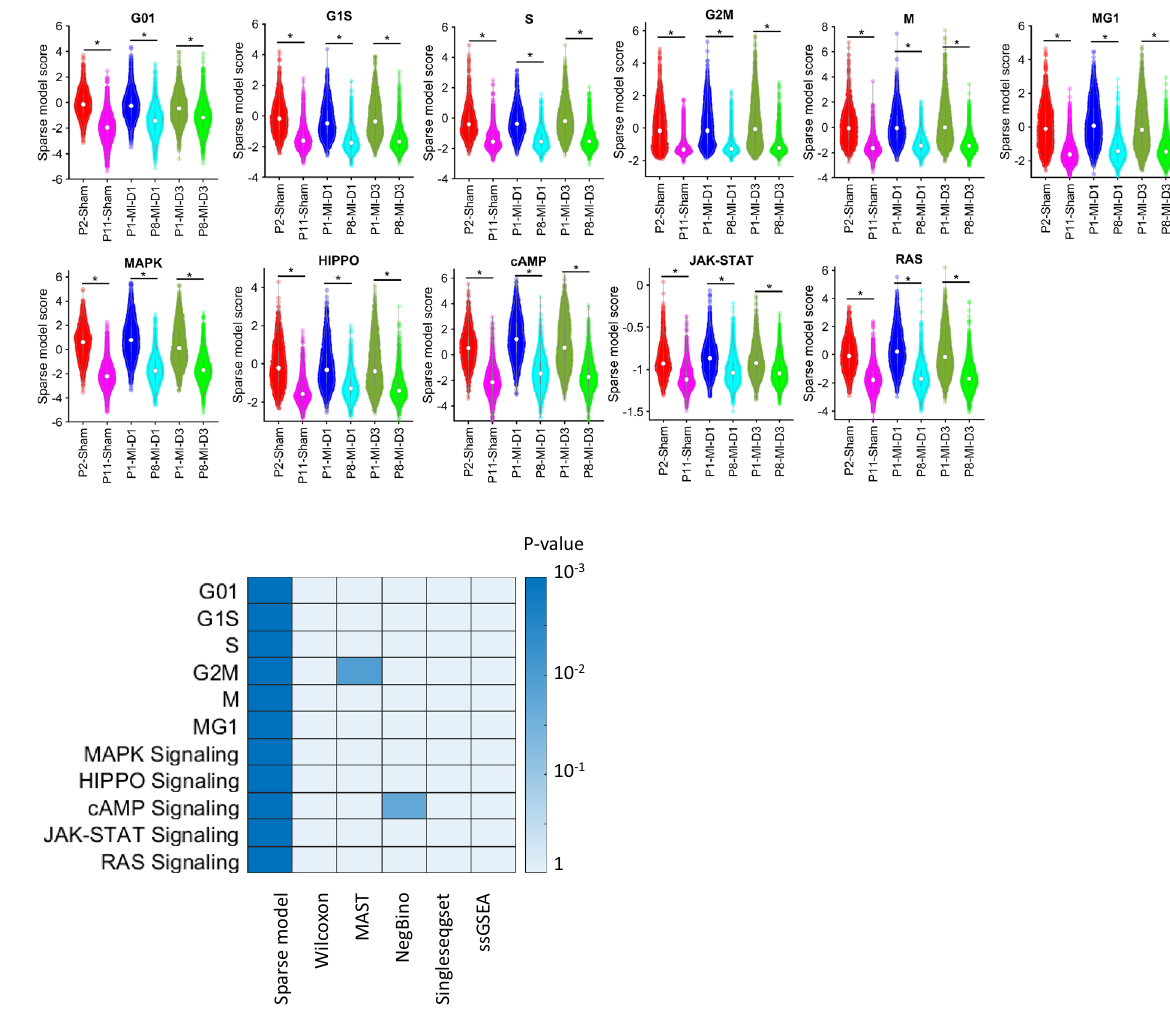
Figure 4. AI Sparse Modeling was more effective than non-AI tools for pathway/gene set enrichment analysis of cardiomyocyte scRNAseq data from mouse hearts. ( A ) Sparse model scores for each cell-cycle phase and for the activity of the MAPK, HIPPO, cAMP, JAK-STAT, and RAS signaling pathways were summarized for cardiomyocytes from the indicated injury groups and time points and presented as violin plots. Statistical comparison between the P1-MI-D1/D3 (regenerative) and P8-MI-D1/D3 (non-regenerative), also between P2-Sham and P11-Sham, were done by non-parametric tests; *p-value < 0.01. ( B ) Cardiomyocytes from the P1-MI-D3 and P8-MI-D3 groups were scored for cell-cycle phase and pathway activity via AI Sparse Modeling, Wilcoxon Ranksum test, MAST, Negative Binomial (NegBino) test, Singleseqset, and ssGSEAP; then, the scores generated by each technique were compared between time points, and the P-values for each comparison was presented as a